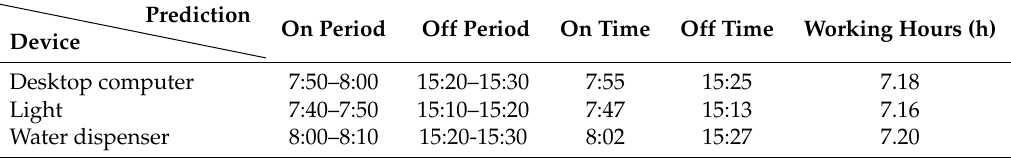
Table 3. Prediction results of energy use